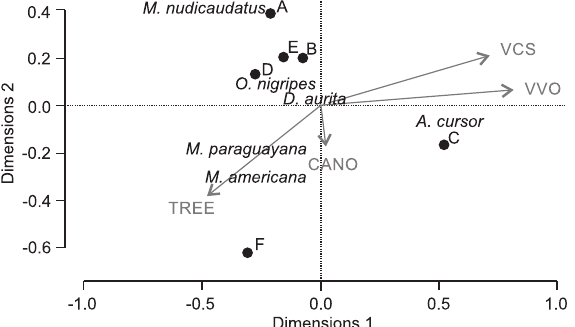
Figure 7. Canonical correspondence analysis (CCA) and relationship among species, transects (A, B, C, D, E, F) and habitat variables (CANO – percentage of canopy cover; TREE – number of trees with diameter at breast height ≥ 5; VCS – percentage of vegetation cover on the soil; VVO – vertical vegetation obstruction) for the 2012–2015 period in CFMA, Rio de